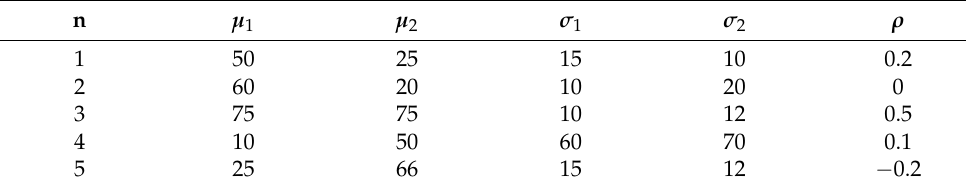
Table 1. Parameters of the potential